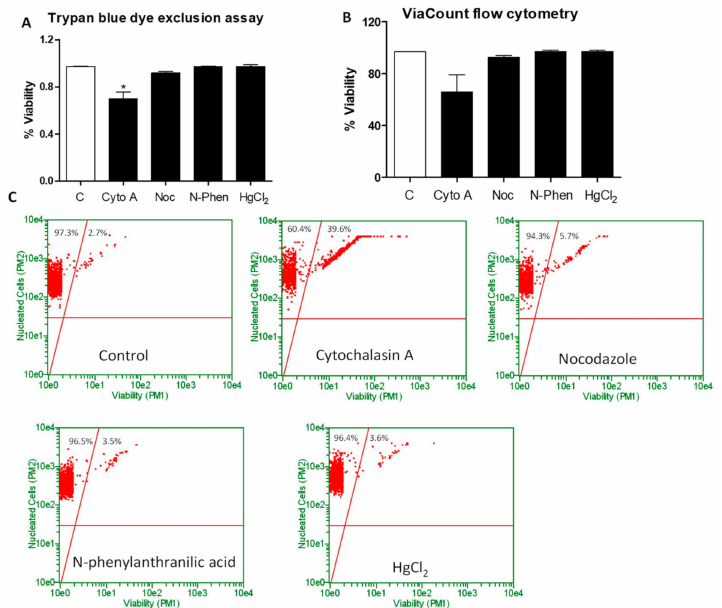
Figure 9. Effect of chemical inhibitors on the viability of cells (ViaCount). THP-1 monocyte-derived macrophages (1 × 10 6 ) cultured as mentioned previously, then harvested, resuspended in HBSS, and treated for 30 min with cytochalasin A (3 µ g/mL), nocodazole (20 mM), N-phenylanthranilic acid (0.1 mM), or mercury chloride (0.075 mM) for 15 min. With media refreshed. Panel A : Then, cells were incubated for a period of 24 h, after which a viability analysis was performed with a hemocytometer cell count using Trypan Blue. Panel B , C , cells were incubated for a period of 24 h before treatment with ViaCount reagent. Then, a viability analysis was performed using a Guava ® easyCyte™ Flow Cytometer (Single Sample System). All data represent mean ± SEM. ( n = 3, *, p < 0.05 vs.